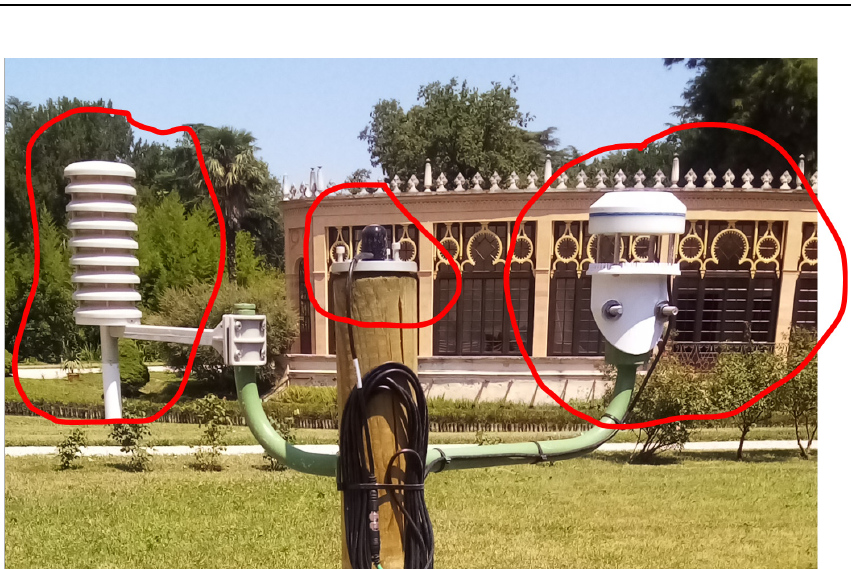
Figure 2. Three sensors positioned at 1.5 m with reference to Table 1 from left to right: Sen-Stk, DL-Pyr, DL-Atm. Circles define the specific position of each sensor model.